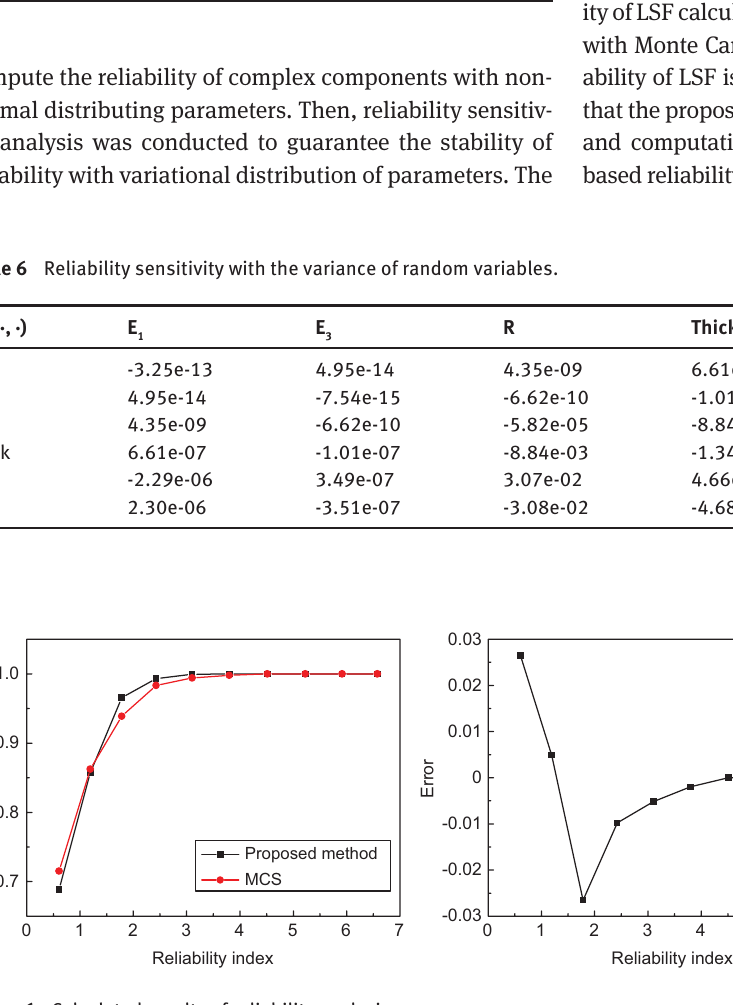
Figure 6 Calculated results of reliability